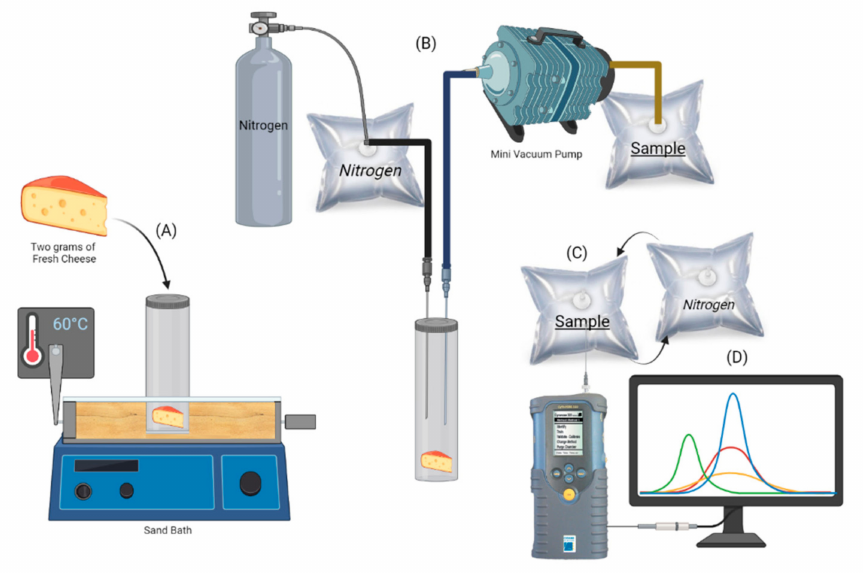
Figure 1. Diagram of the analysis two types of F-MC. ( A ) Incubation of F-MC sample for 15 min at 60 ◦ C; ( B ) Absorption of VOCs in a Tedlar bag; ( C ) Data processing and pattern recognition. After each sample read, the e-nose required a purge using nitrogen gas ( D